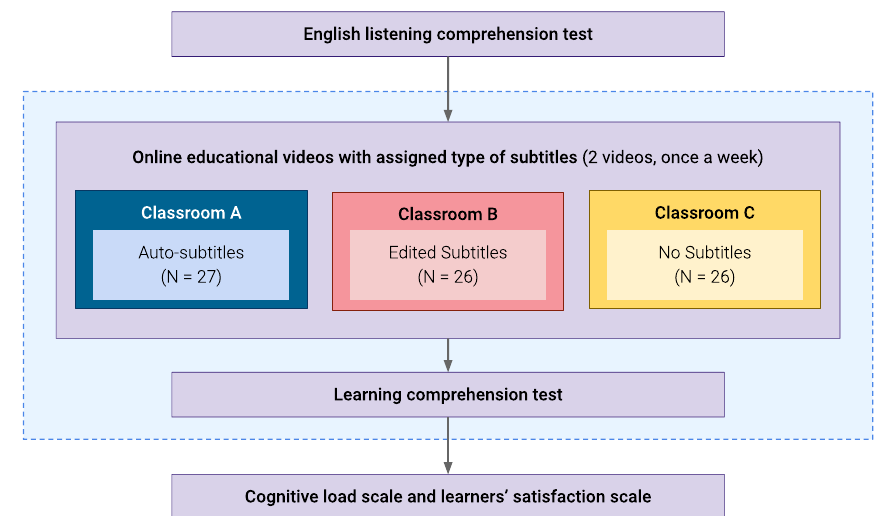
Fig. 1 Experimental procedure process